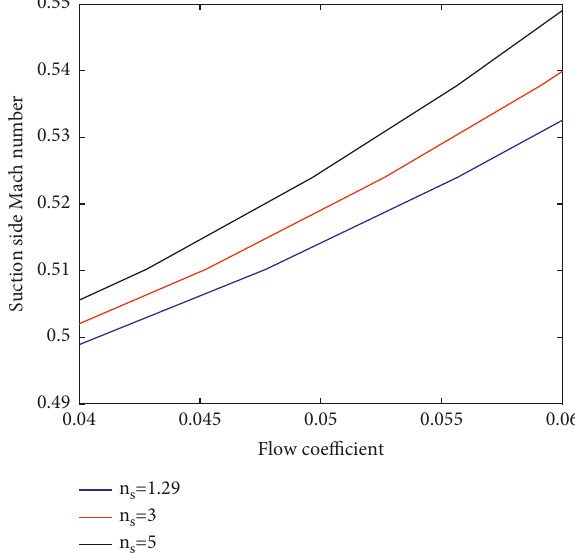
Figure 6: Isentropic exponent effects on the impeller outlet Mach number.